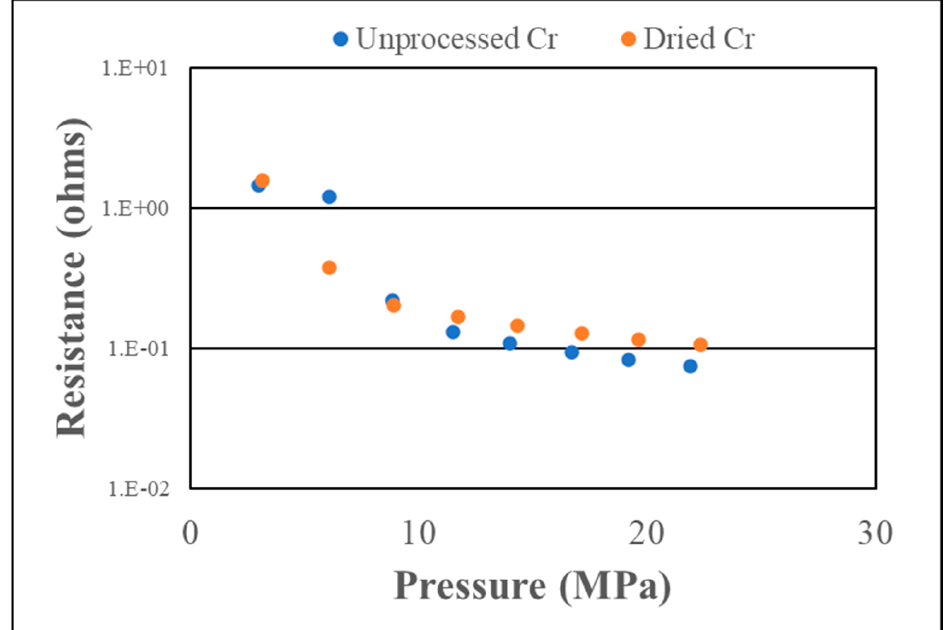
Figure 15. Powder compressibility data for evaluated Cr powders.